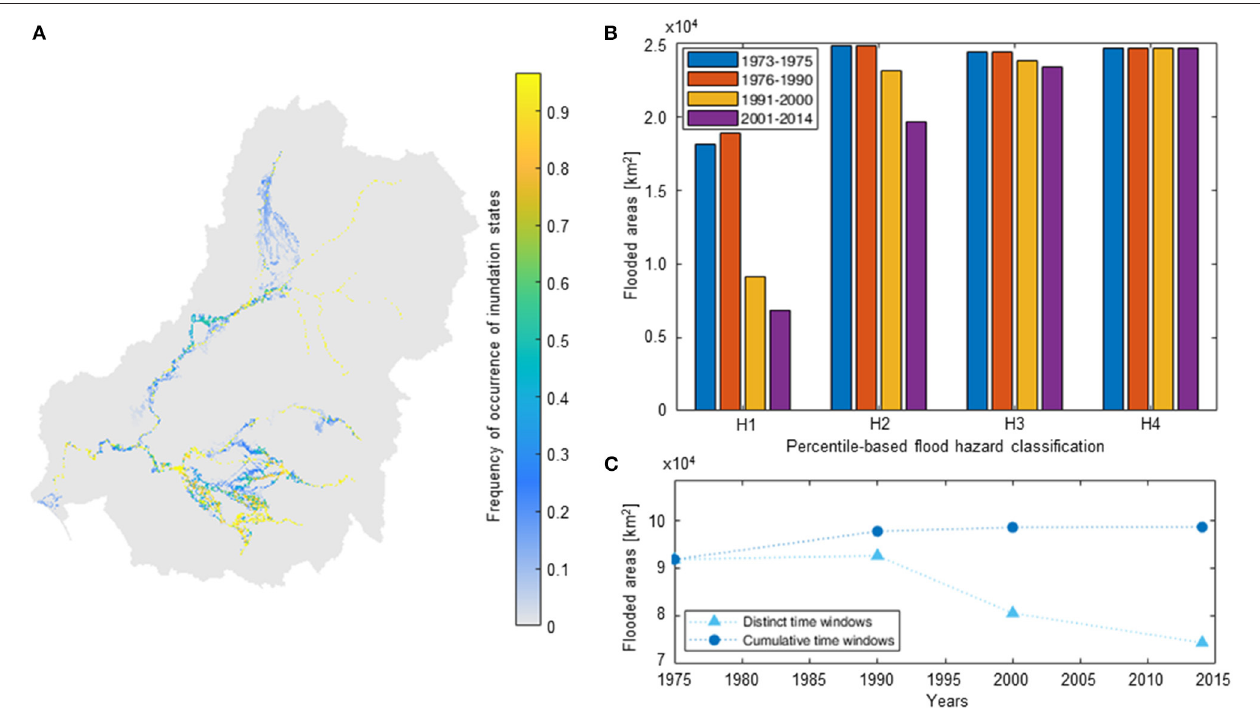
FIGURE 3 | Flood hazard assessment across the MDB from 1973 to 2014. (A) Geographical representation of the frequency of occurrence of inundation states. (B) Temporal evolution of the maximum extension of flooded areas (in km 2 ) in each flood hazard category (percentile-based classification). (C) Temporal evolution of the maximum extension of flooded areas (in km 2 ), as derived from distinct (light blue triangles) and cumulative (dark blue circles)